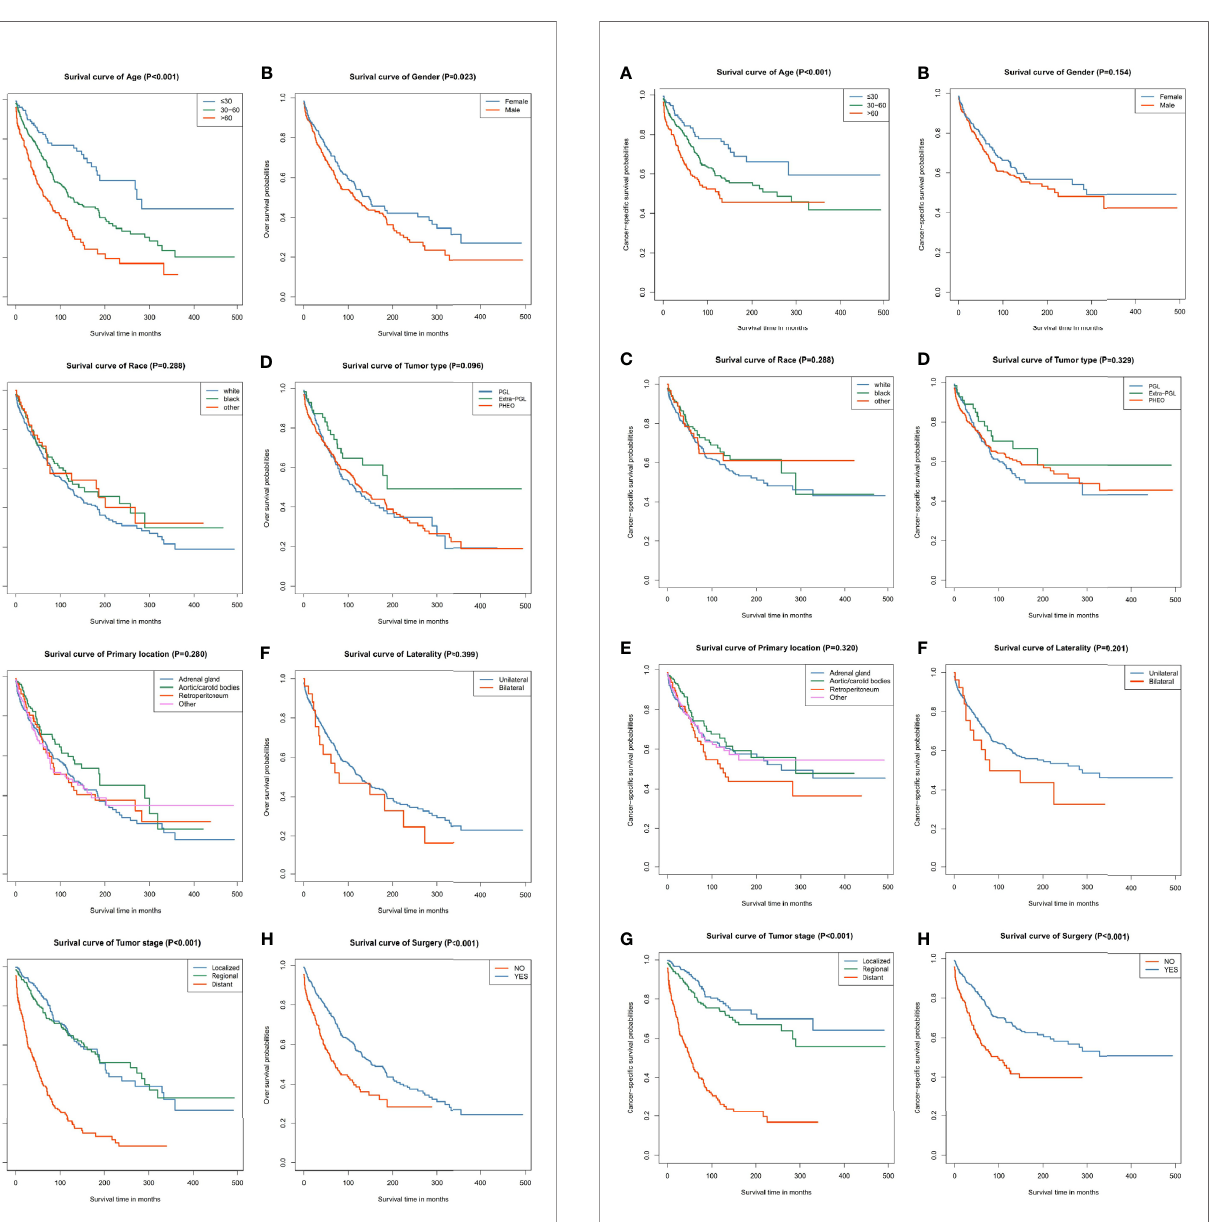
FIGURE 3 | Kaplan – Meier curves of overall survival for patients based on: (A) age; (B) gender; (C) race; (D) tumor type; (E) primary location; (F) laterality; (G) tumor stage; (H) surgery.